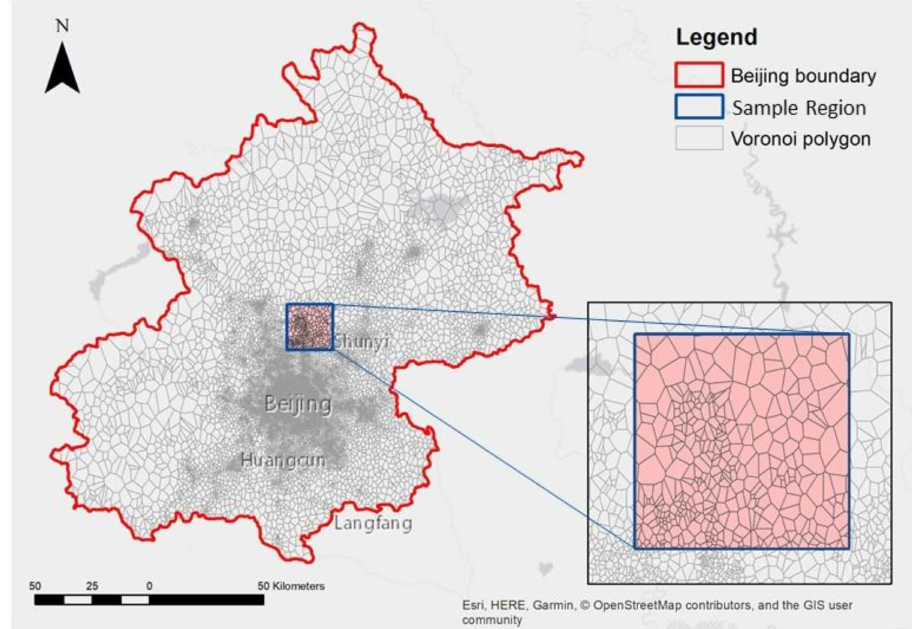
Figure 6. The sample region of base station Voronoi polygon in an experiment.